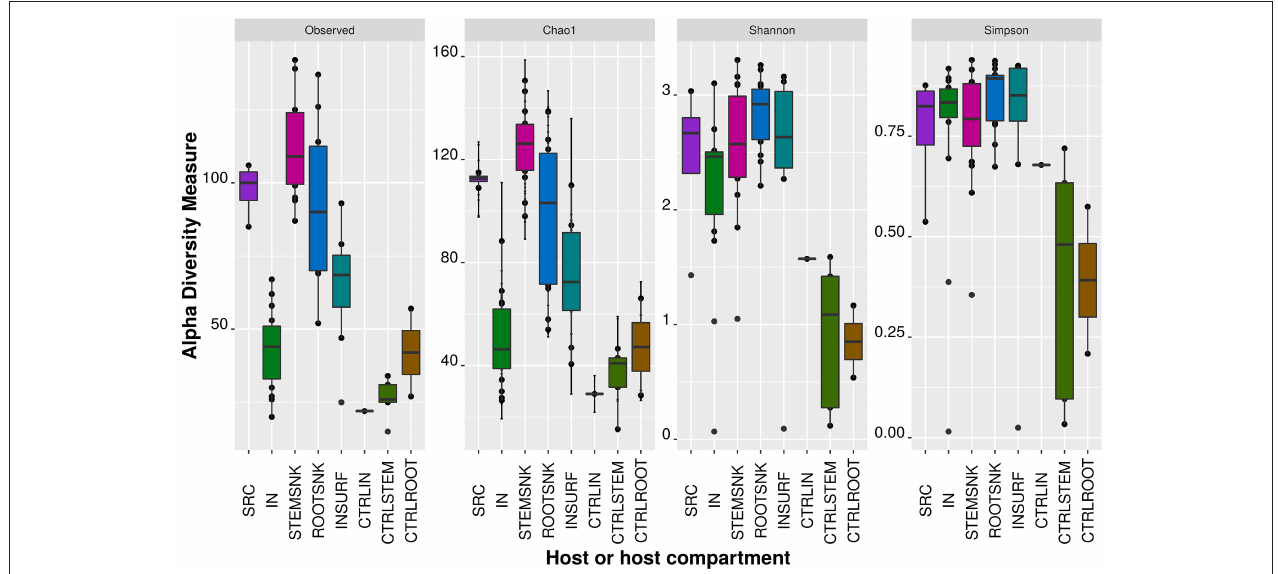
FIGURE 3 | Alpha diversity measures on transmission experiments. Alpha diversity indexes (Richness: Observed species, Chao1 ; Diversity: Shannon-Wiener, and Simpson) were calculated on the OTU table at the phylum level. Reads were rarefied to 1,300 sequences to have an even representation of OTUs in each sample category (or